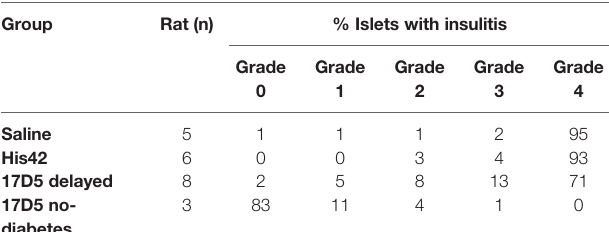
TABLE 2 | Evaluation of insulitis in the DR Lyp/Lyp rats.